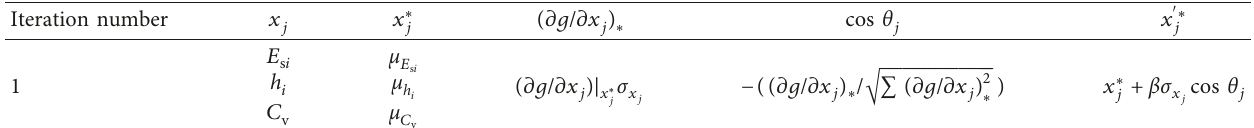
Table 3: Iterative